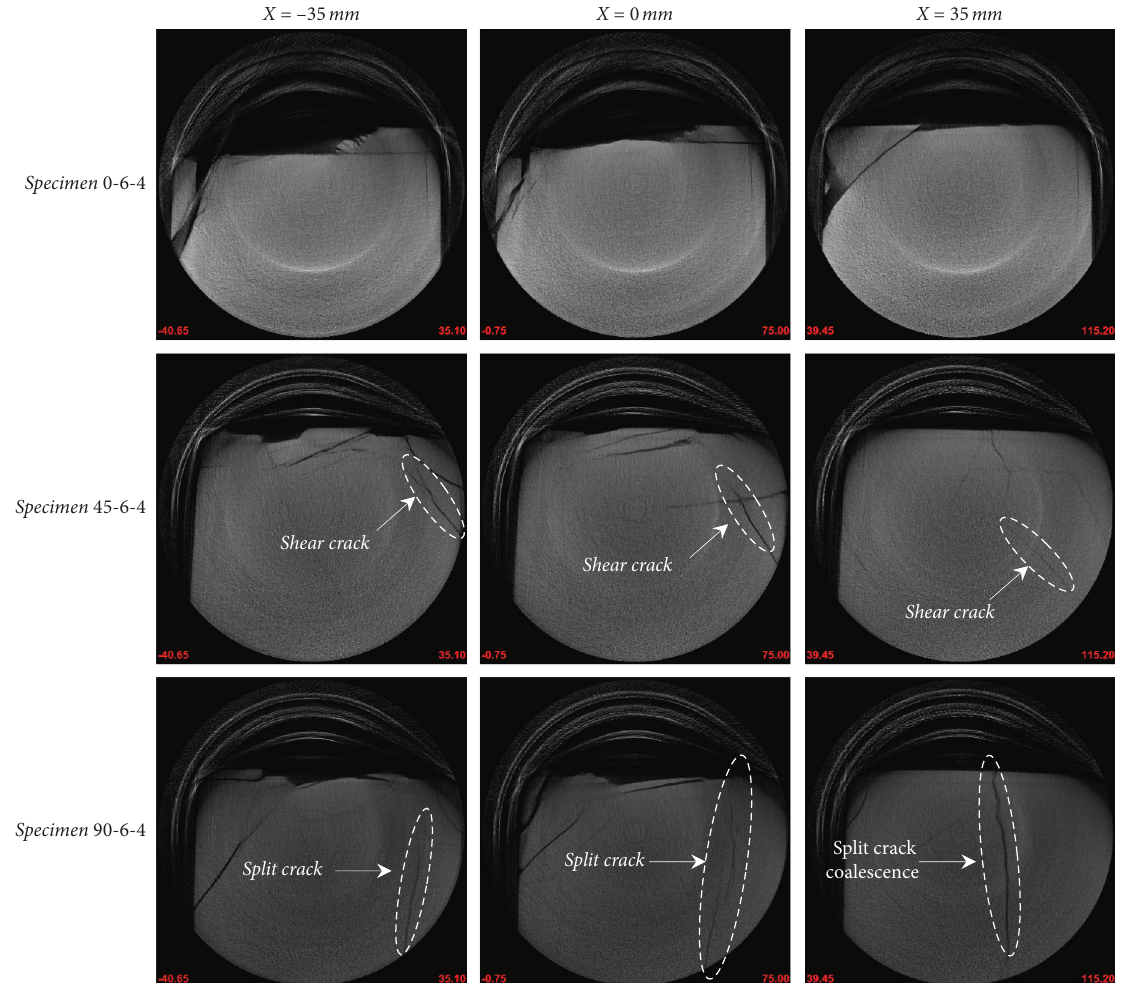
Figure 13: CT images in the X plane for the α � 0 ° , 45 ° , and 90 ° specimens under a maximum principal stress of